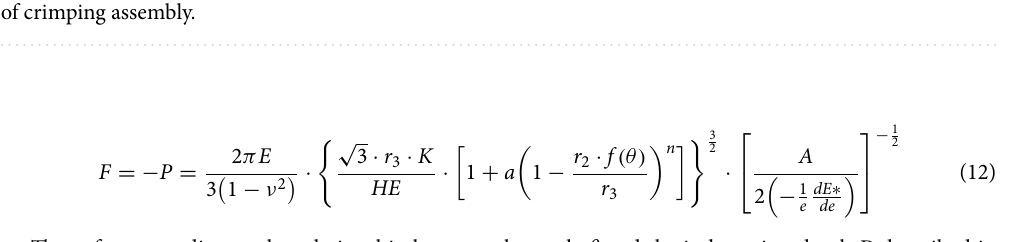
Table 2. Tensile test values of the first to fifth groups of crimping samples and the corresponding failure types of crimping assembly.